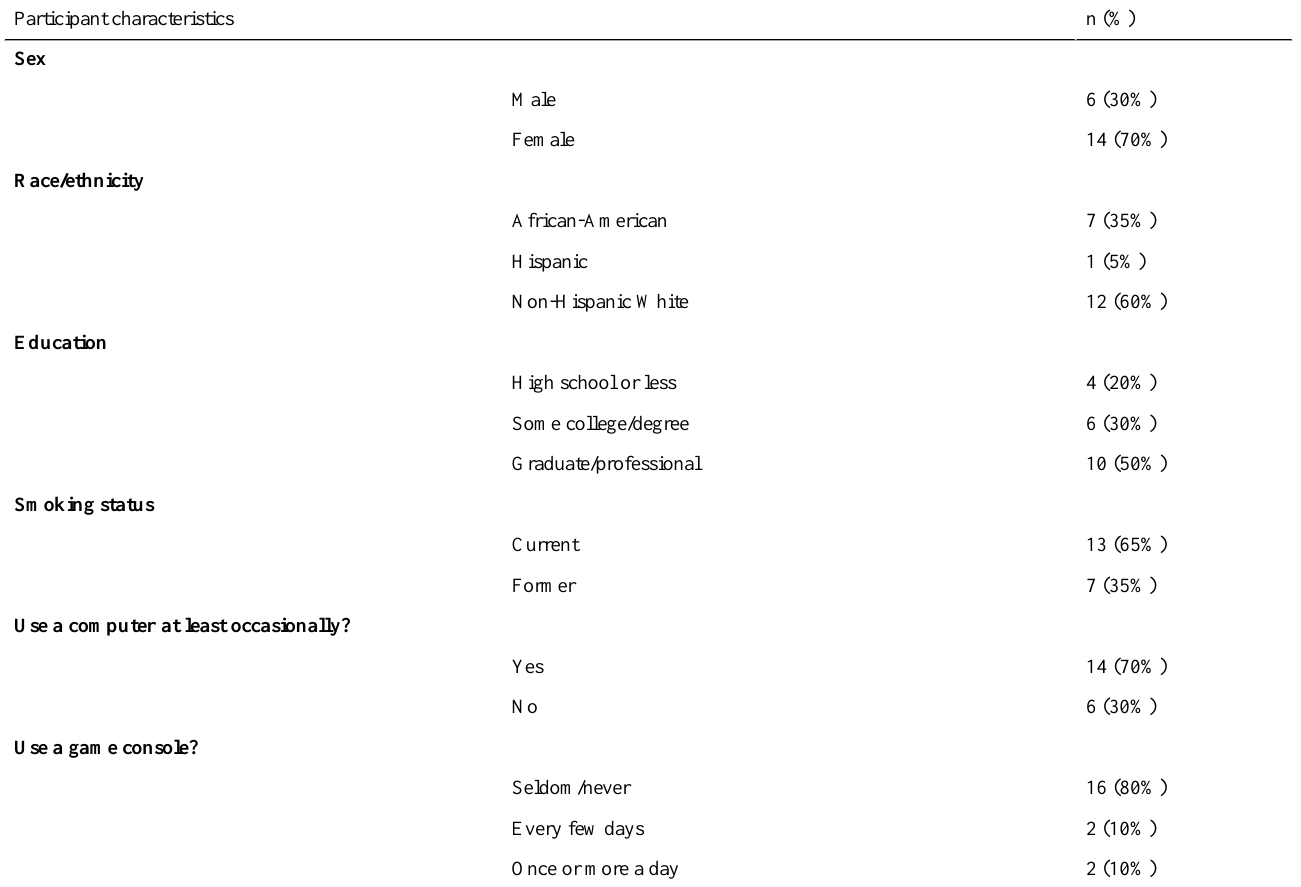
Table 2. Phase I prototype evaluation: participant characteristics